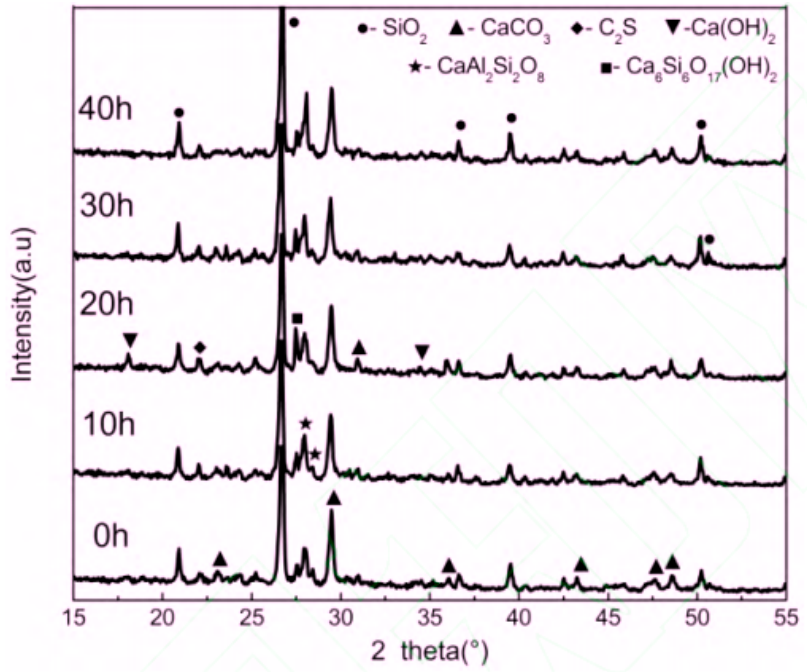
Figure 4. XRD patterns of recycled powder with different grinding times.